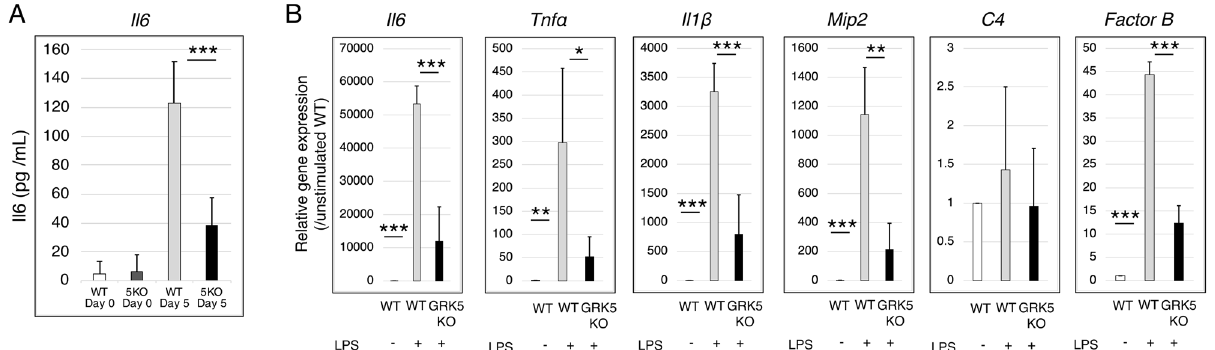
Figure 5. Serum IL6 production after LPS injection in a CAIA model and effects of GRK5 knockout on the expression of inflammatory genes after LPS stimulation in murine BMDMs. ( A ) Changes in IL6 production after LPS injection in GRK5 knockout (KO) and WT mice during CAIA. Values are means ± SD (n = 3 per each group). *** P < 0.001 versus WT mice. ( B ) Changes in gene expressions in response to LPS stimulation in GRK5 KO and WT murine BMDMs. Values are means ± SD (n = 3). * P < 0.05; ** P < 0.01; *** P <